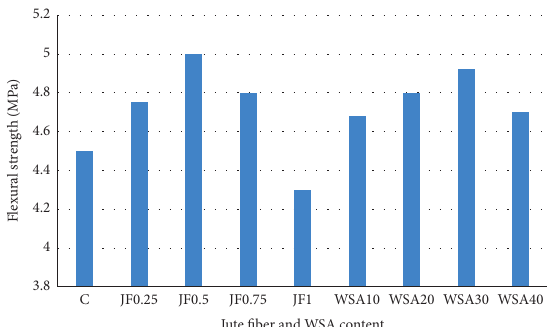
Figure 8: Flexural strength of mixture containing jute fiber and